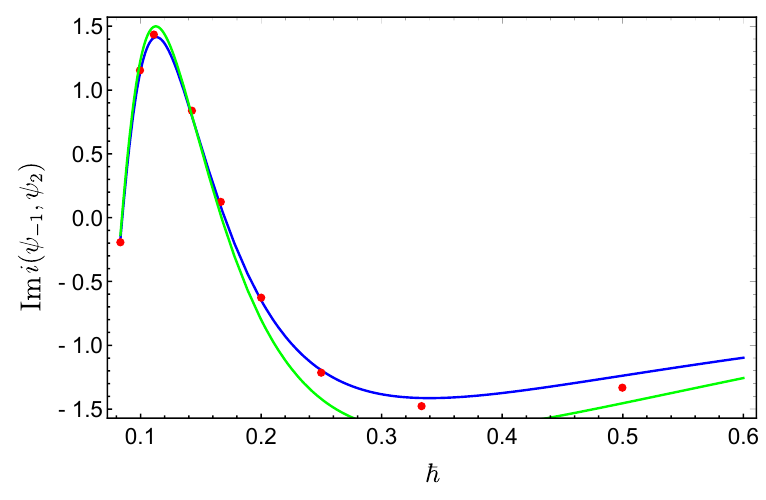
Figure 8 . Evaluations of the Wronskian i ( ψ − 1 , ψ 2 ) . The red dots are the numerical result. The blue line and the red line are the analytic prediction from the local coordinate system around the double zero up to ~ − 1 and ~ order respectively given in